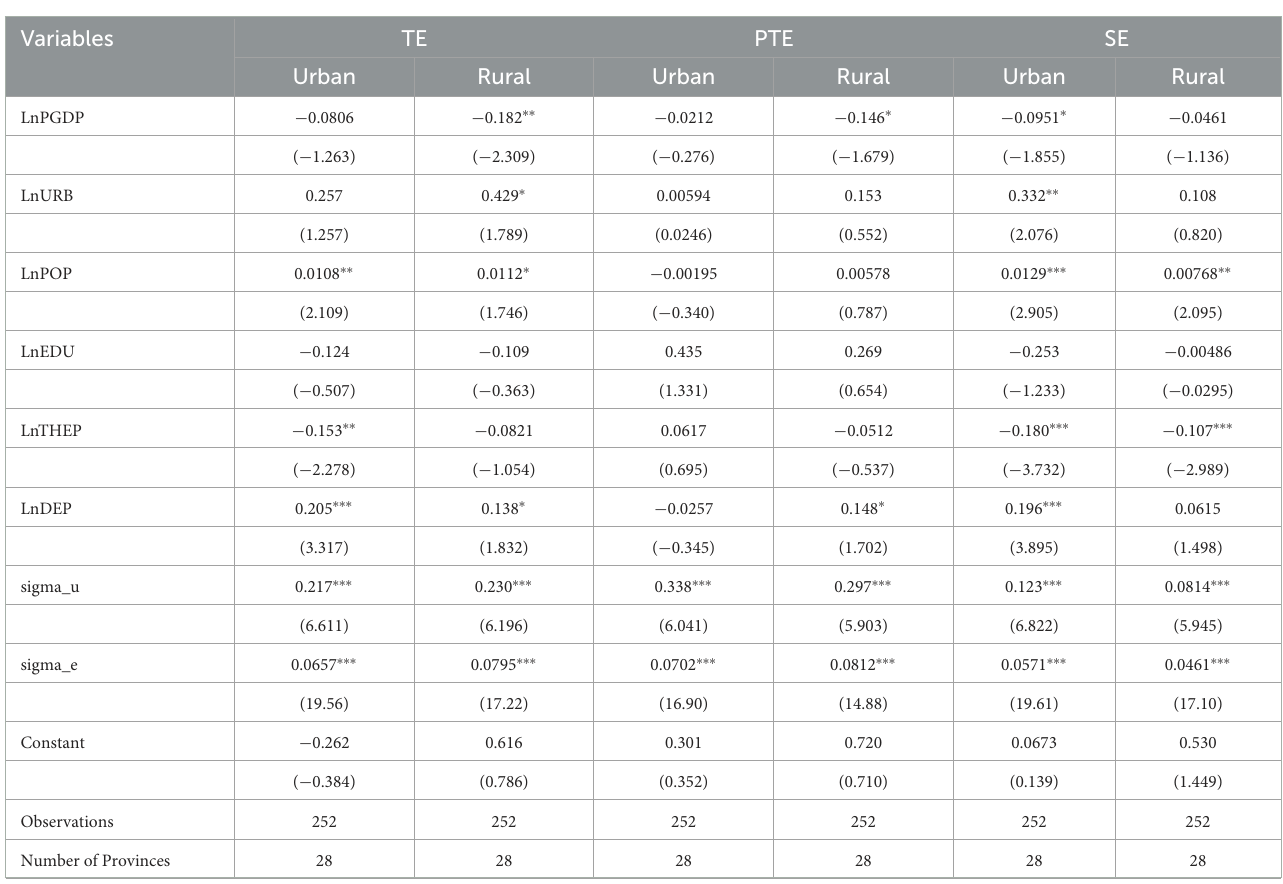
TABLE 7 Regression results of the DEA-Tobit panel model.